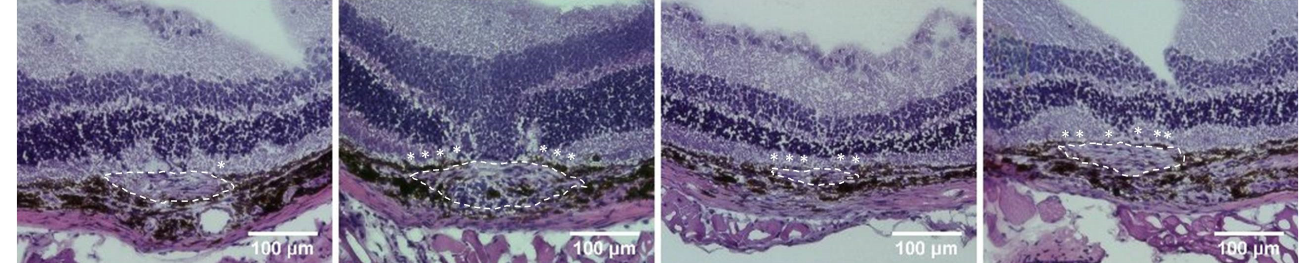
Figure 3. H&E staining on Day 15 (10 days after laser photocoagulation). Left to right: Laser-only group, 2 h group, 5 h group, and 2.5 h/2.5 h group. The shape of the CNV (white dotted line) became flattened after hydrogen inhalation. More RPE coverage (dark-pigmented tissue labeled with an asterisk) over the CNV tissue was also noted after hydrogen inhalation.